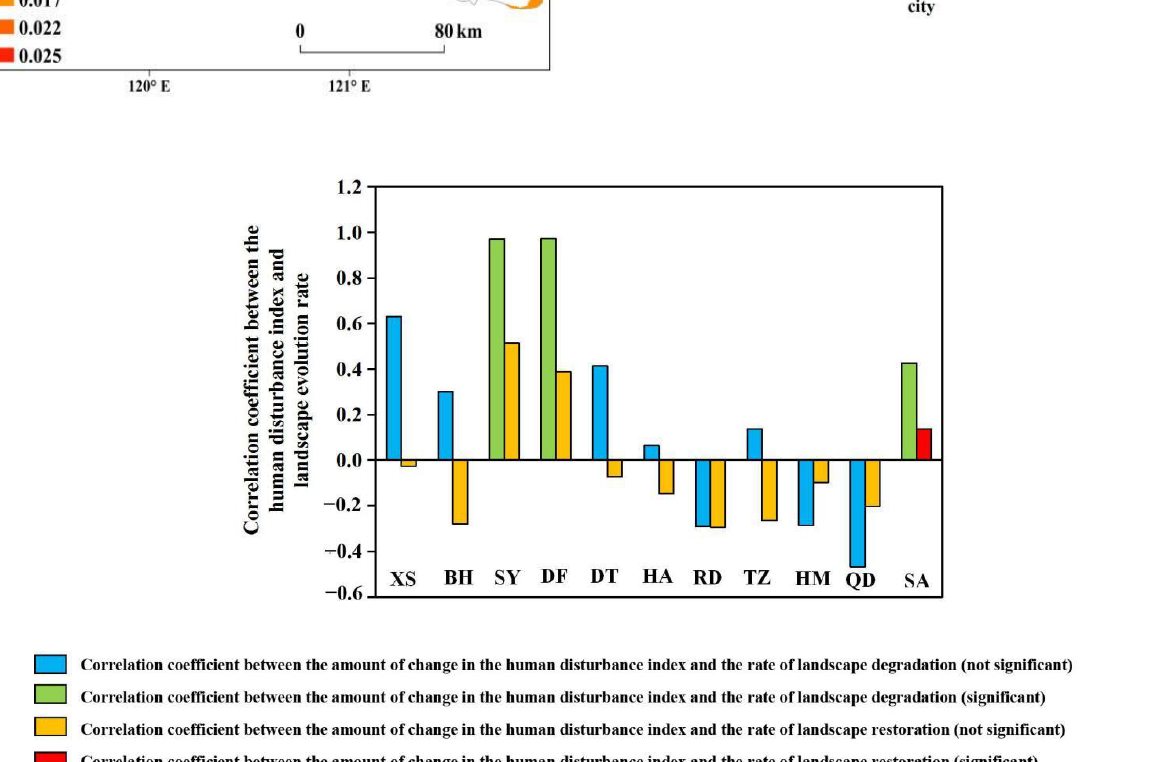
Figure 8. The variation trend for the human disturbance index and the correlation with landscape evolution, ( a ) trends of the human disturbance index in Yancheng city, Nantong city and the whole study area, ( b ) the average value of the human disturbance index in each county and city from 1980–2020, ( c ) trends of the human disturbance index by counties and cities during 1980–2020, ( d ) correlation between the human disturbance index and landscape evolution rate in counties, cities and study